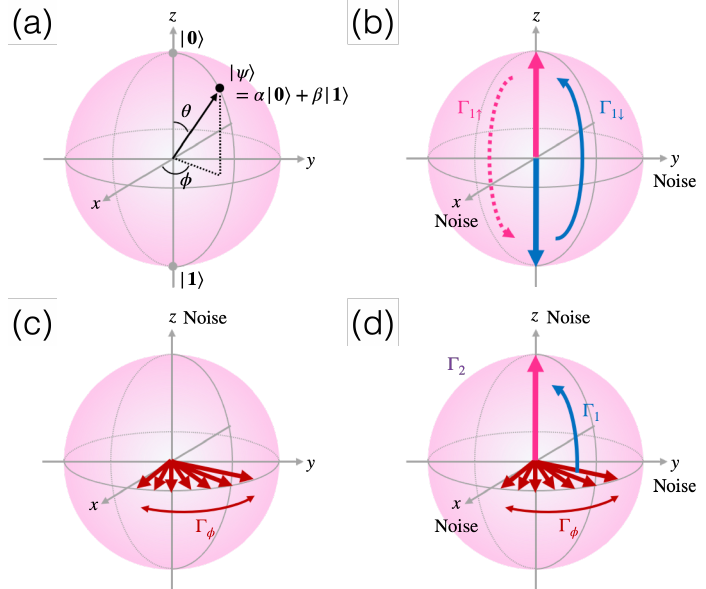
Figure 1. ( a ) A Bloch sphere to locate a qubit state: the ground state and the excited state are represented along the z -axis as | 0 (cid:105) and | 1 (cid:105) at the north and south poles, respectively. The z -axis acts as a longitudinal direction, whose transverse axes are along the x and y directions. ( b ) Longitudinal relaxation rates ( Γ 1 s , where s = ↑ or ↓ ) induced by the energy exchange between two spin states caused by transverse noise sources in the x − y plane. ( c ) A pure dephasing rate ( Γ φ ) in the transverse plane due to adiabatic perturbations along the z axis. Adiabatic perturbation means that a system evolves according to slow degrees of freedom. ( d ) Transverse relaxation rate ( Γ 2 ) from a combination of Γ 1 /2 and Γ φ . The above images are reconstructed from Figure 4 in Ref. [2] with the permission